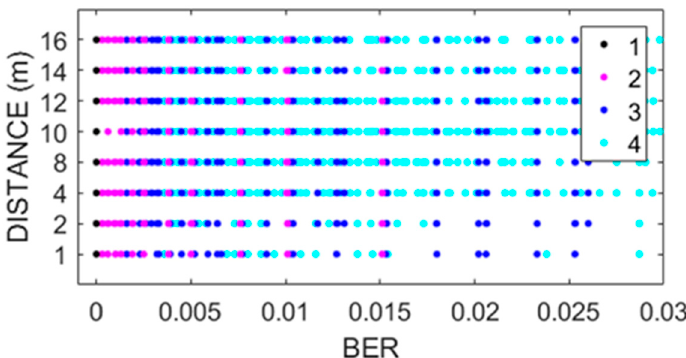
Figure 2. Scatterplot of distance against BER.